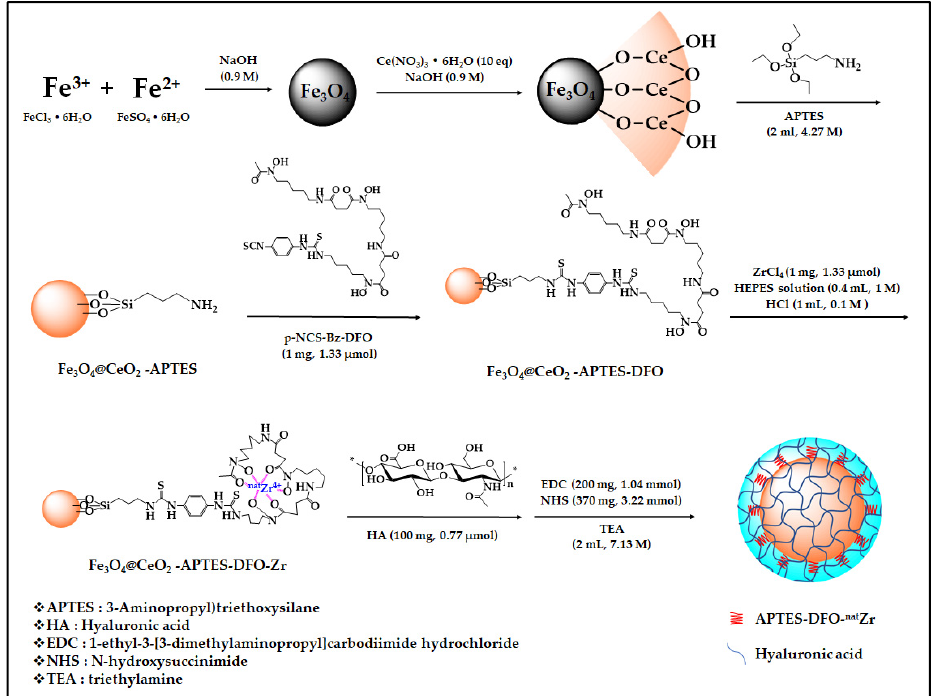
Figure 1. Total scheme of drug delivery system synthesis.